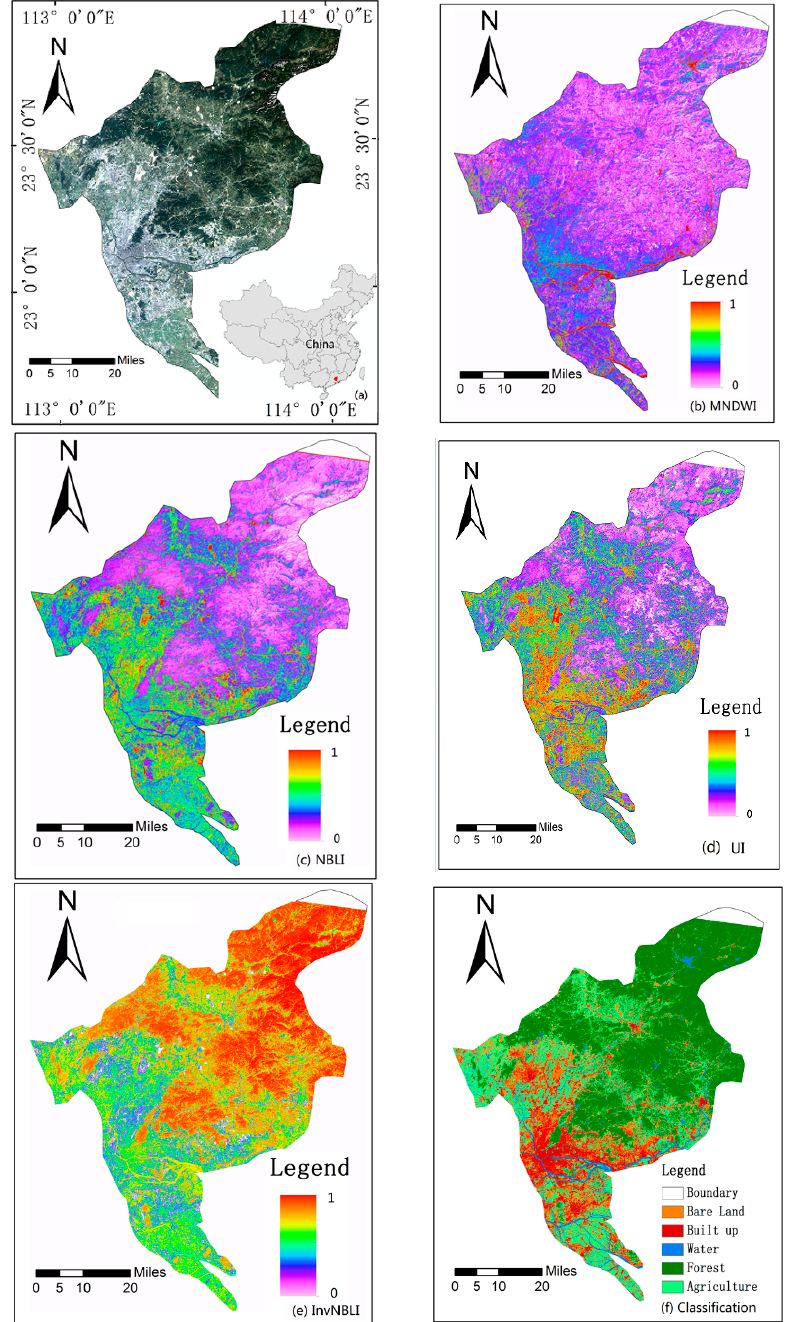
Figure 8. An example test in Guangzhou City. ( a ) The Landsat image of the city on 2 November 2009; ( b ) the MNDWI image in psudo-color; ( c ) the NBLI image in psudo-color; ( d ) the UI image in psudo-color; ( e ) the inverse NBLI image in psudo-color; and ( f ) the unsupervised classification result.